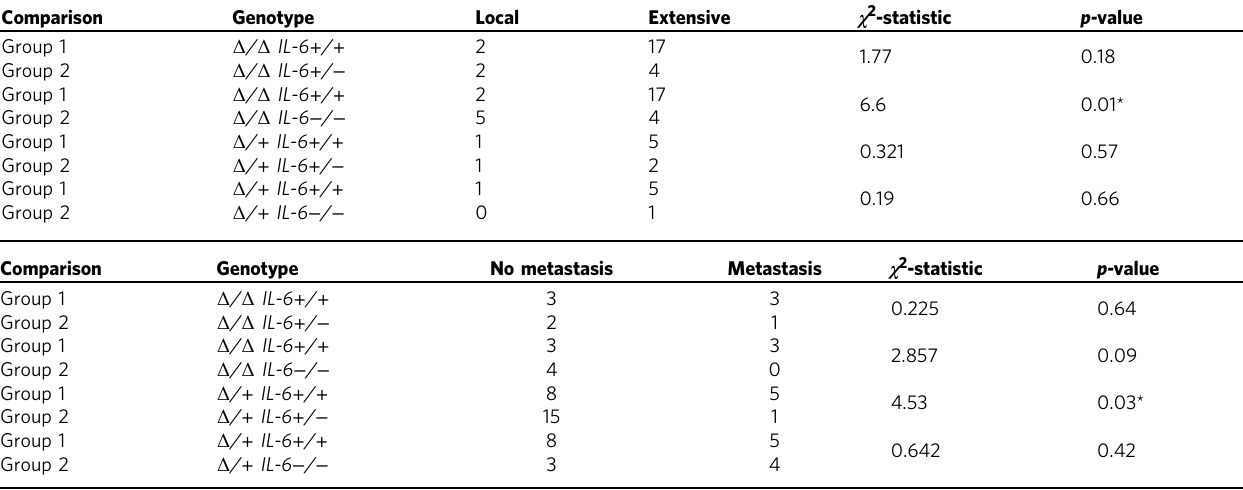
Table 2 Loss of IL-6 leads to reduced metastatic spread of tumours in Δ 122p53 mice Comparison